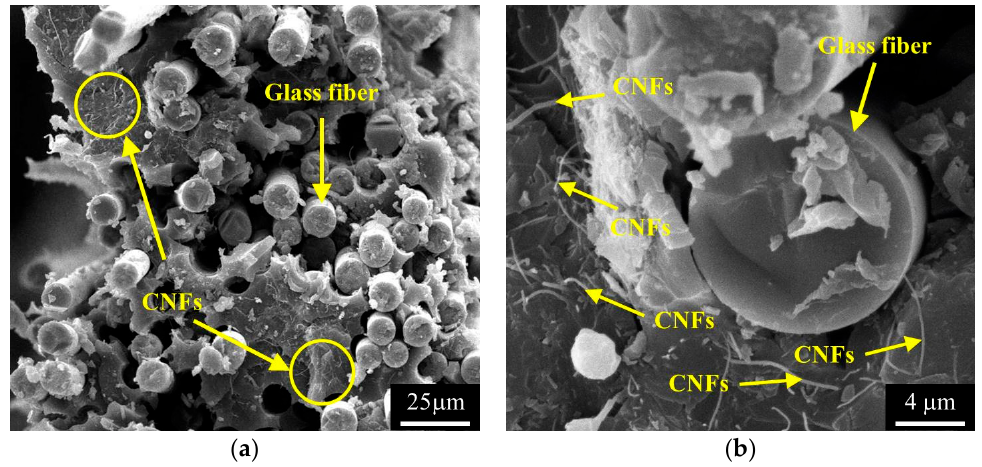
Figure 6. SEM images of fracture surfaces: ( a ) L 1.0 ; ( b ) L 1.5 .